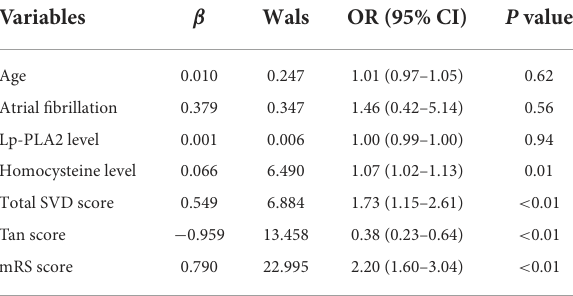
TABLE 2 The multivariate logistic regression analysis of Model 1.